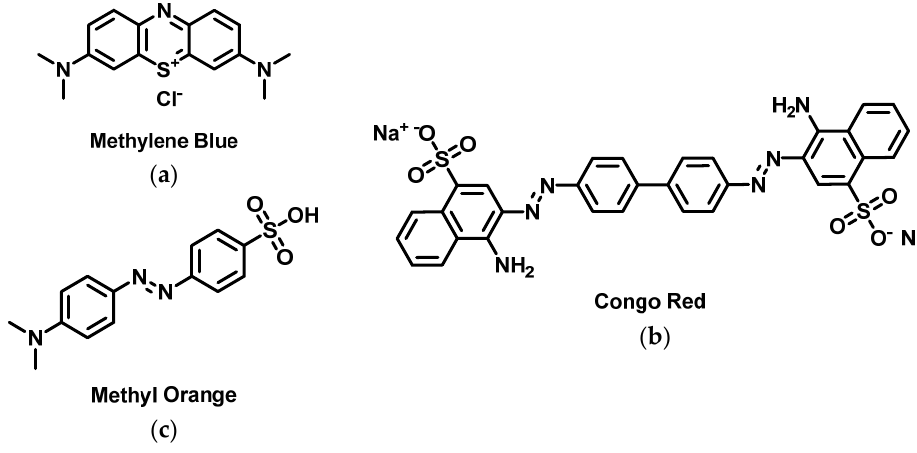
Figure 15. Structure of methylene blue ( a ), Congo red ( b ) and methyl orange ( c